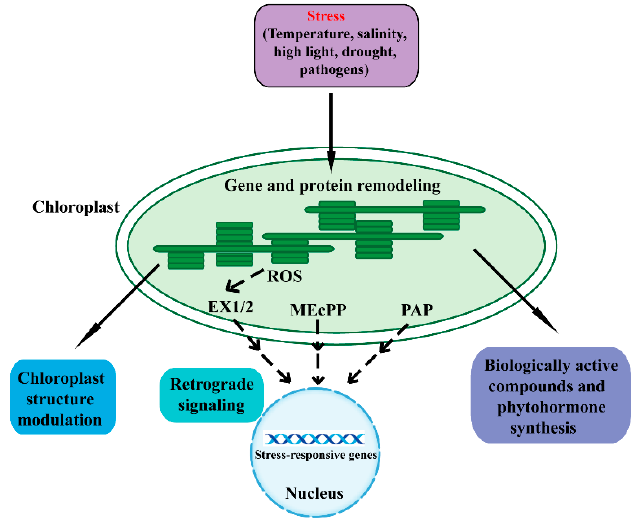
Figure 1. An overview of the various mechanisms in chloroplast response to adverse stresses. Ad- verse environmental stresses cause perturbations and generate signals in chloroplasts that regulate chloroplast gene expression and protein remodeling. A series of cellular activities are then triggered to restore chloroplast homeostasis. Adverse conditions can affect the structure, function, and devel- opment of chloroplasts. Chloroplasts synthesize biologically active compounds and phytohormones to acclimate to stresses. Moreover, the chloroplast is able to communicate its status to the nucleus through retrograde signaling to regulate nuclear stress-responsive genes. The SAL1/PAP, MEcPP, and ROS pathways act as important components of the chloroplast retrograde signaling pathway. Dashed lines indicate postulated regulation. ROS, reactive oxygen species; EX1/2, executor 1/2; MEcPP, methylerythritol cyclodiphosphate; PAP, phosphonucleotide 3 ′ -phosphoadenosine 5 ′ - phosphate.